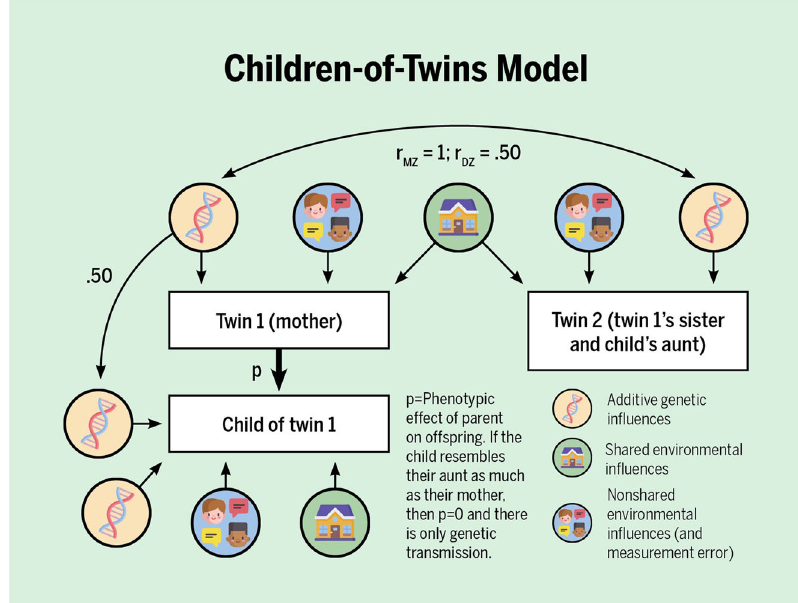
Fig. 5 Simpli fi ed representation of the children-of-twins model. In the given example, the (adult) twins are sisters. The genetic transmission (left hand side) is fi xed at 0.50 because parents and children share 50% of their genome. The other set of genes that in fl uence the child trait (bottom left) are genetic in fl uences that explain variance in the child trait but not the parent trait. The crucial test for presence of environmental transmission is whether the p-path is signi fi cant. Note that ‘ child ’ can refer to child or adult offspring. See, for the full and detailed model, ref. 31 . Figure by ref. 66 available at https://bit.ly/2D0aNYJ under a CC BY 4.0